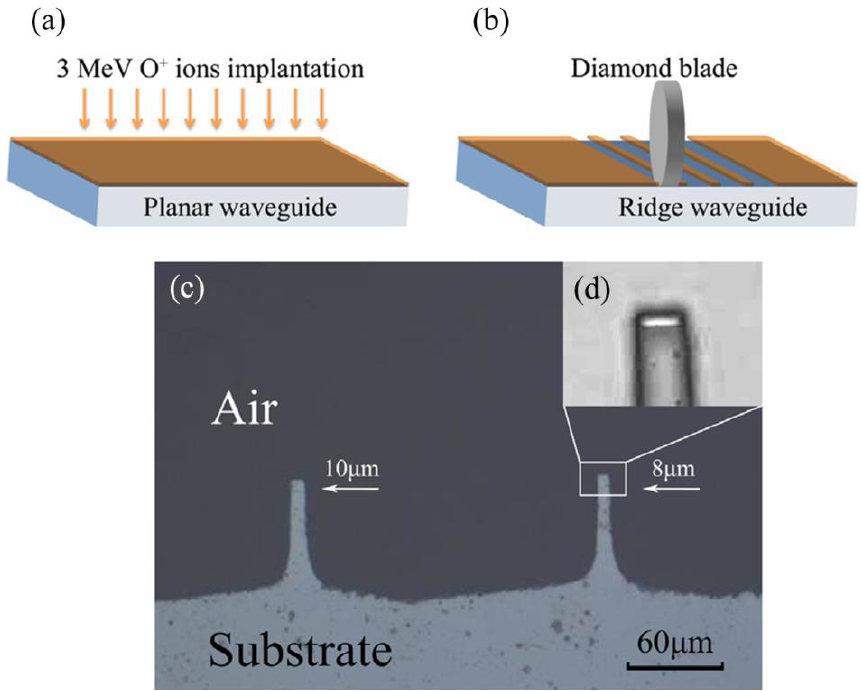
Figure 21. Schematics of ( a ) 3 MeV oxygen ion implantation; ( b ) diamond blade dicing; ( c ) cross- sections of the ridge waveguides; ( d ) transmission optical microscopy image showing a close-up of the ridge waveguide [99].Adapted with permission from Ref. [99]. 2014, Elsevier.